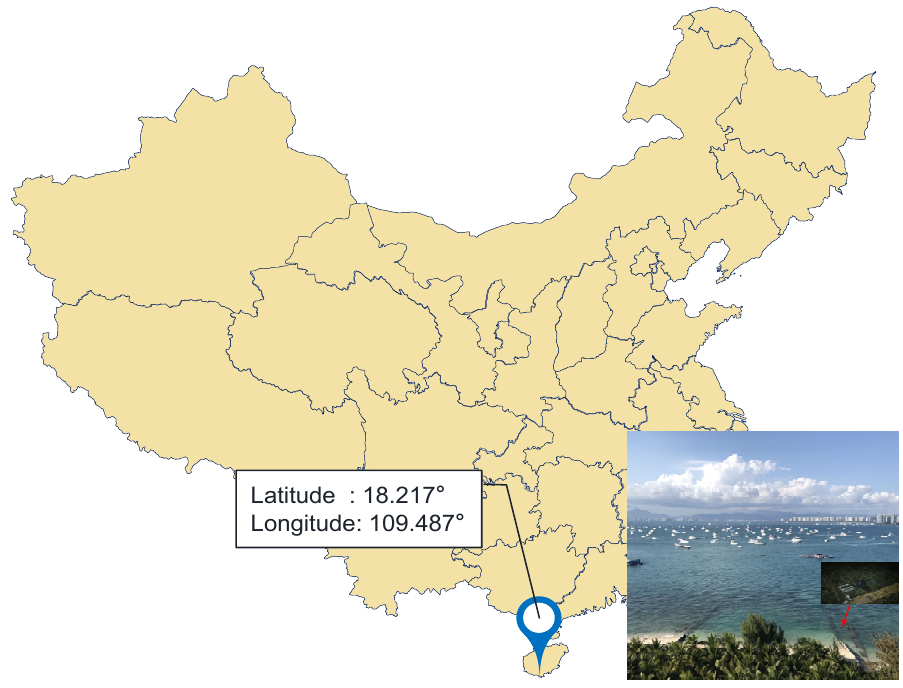
Figure 10. The in-situ test site is located at 18.217° north latitude and 109.487° east longitude.